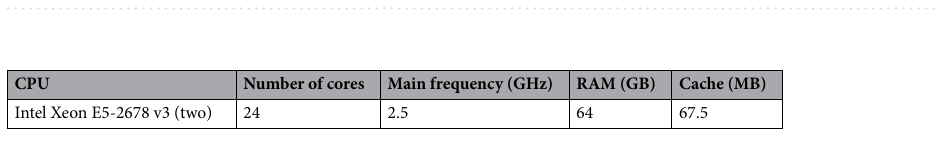
Table 2. Scale and efficiency of finite element calculation model.